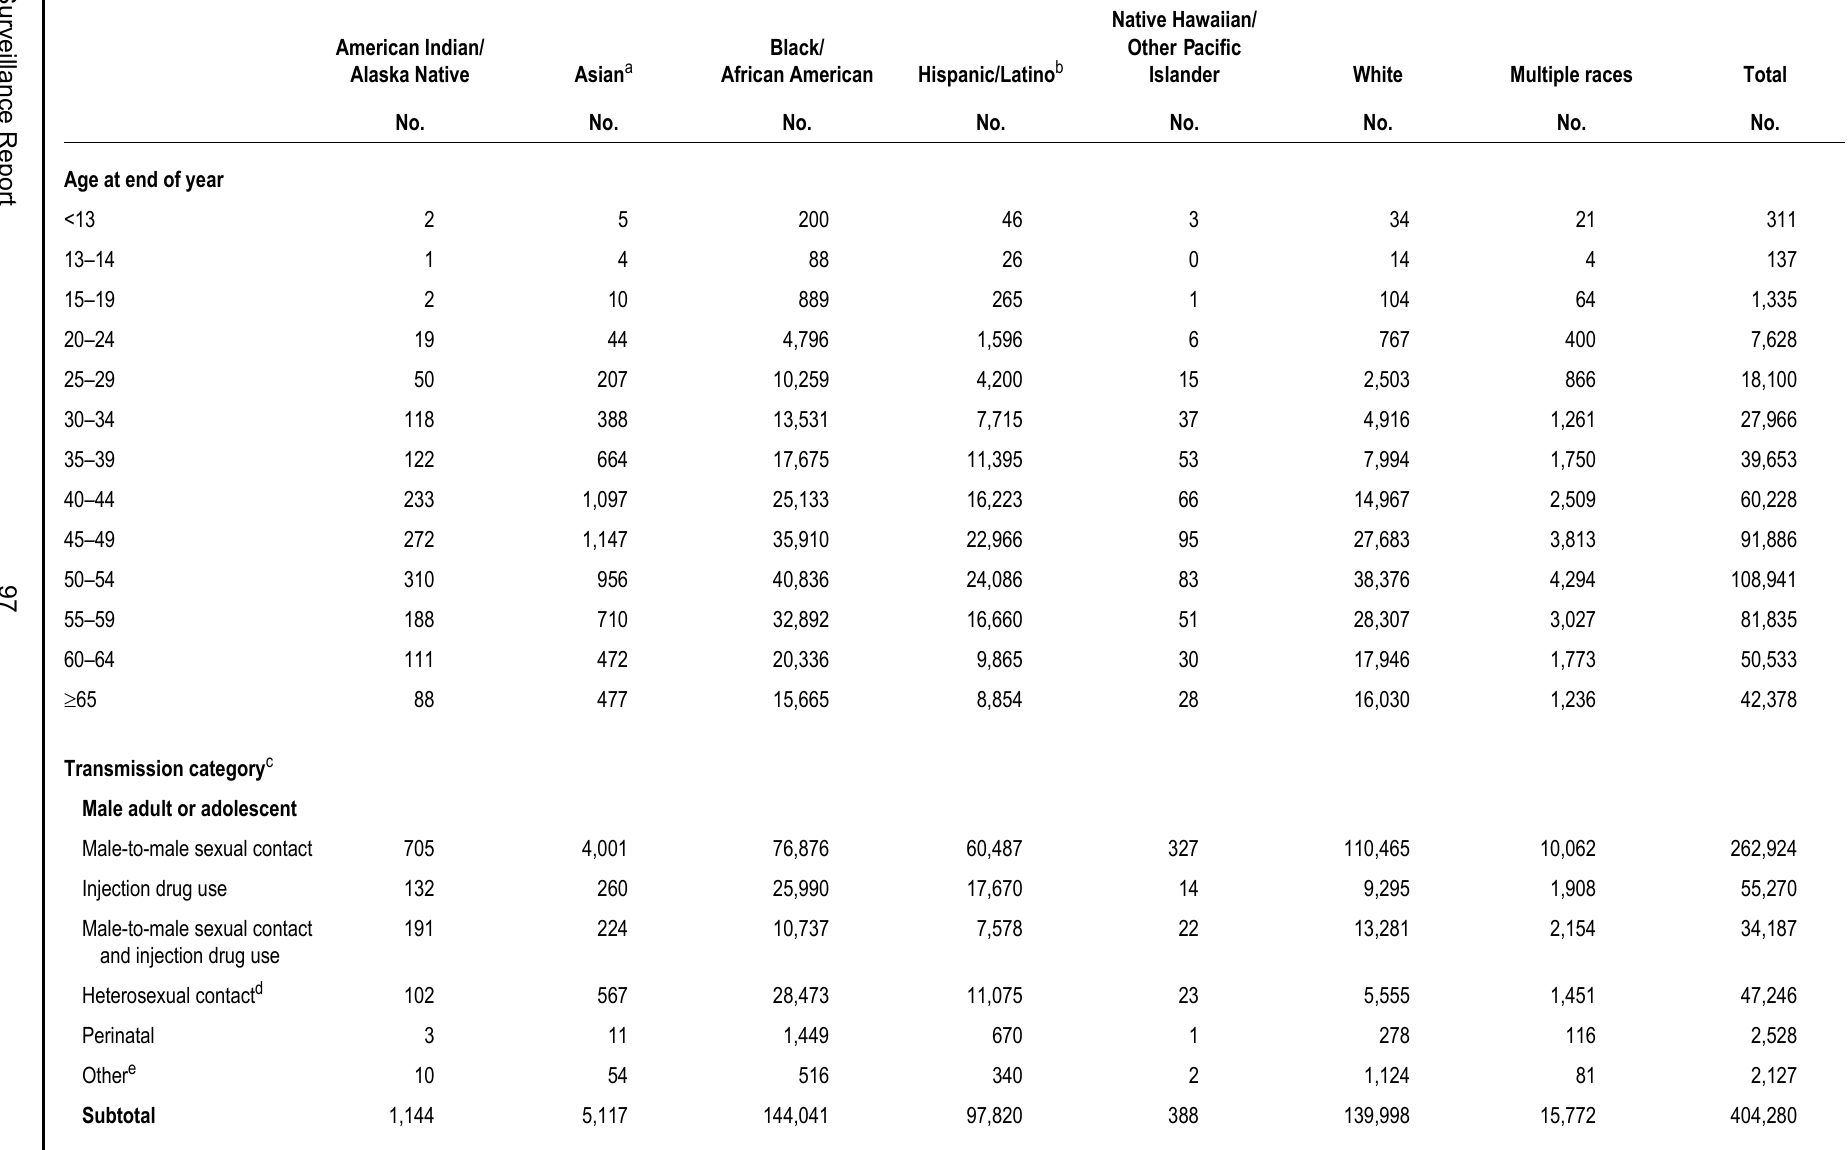
Table 21b. Persons living with diagnosed HIV infection ever classified as stage 3 (AIDS), by race/ethnicity and selected characteristics, year-end 2014—United States and 6 dependent areas